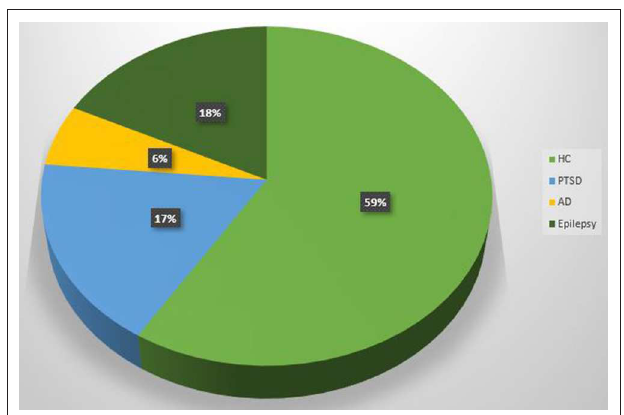
FIGURE 4 | Pie chart. Proportion of EEG-fMRI studies in relation to neuropsychological impairments and healthy control